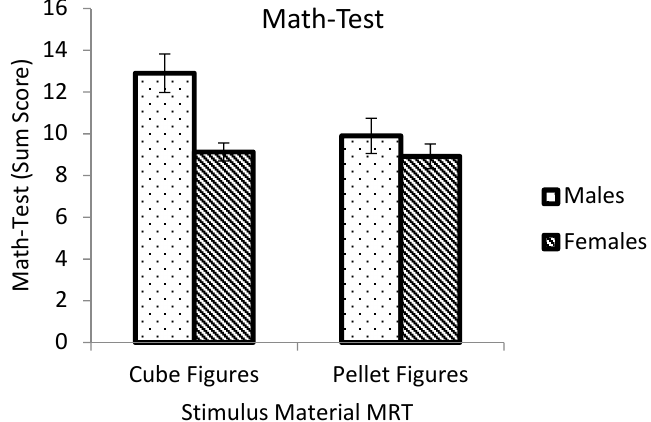
Figure 3. Math-test performance as a function of rotational objects of the previously solved MRT and participants’ gender. Error bars indicate SE.